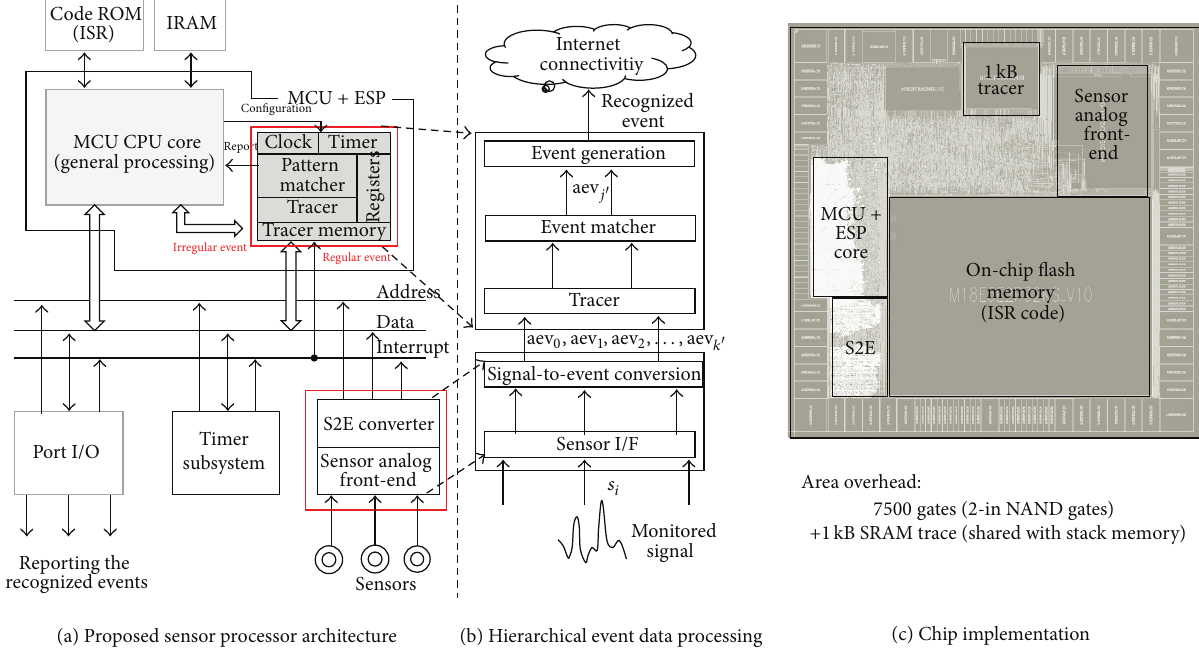
Figure 9: VLSI IC implementation of microcontrollers with the proposed event signal processing unit (EPU).